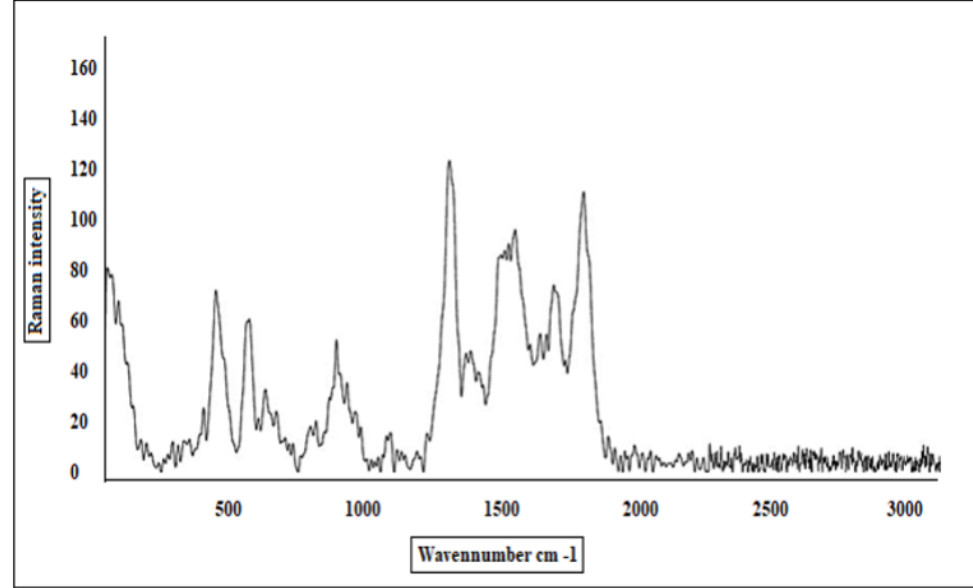
Figure 6. Raman spectrum of the prepared PANI.